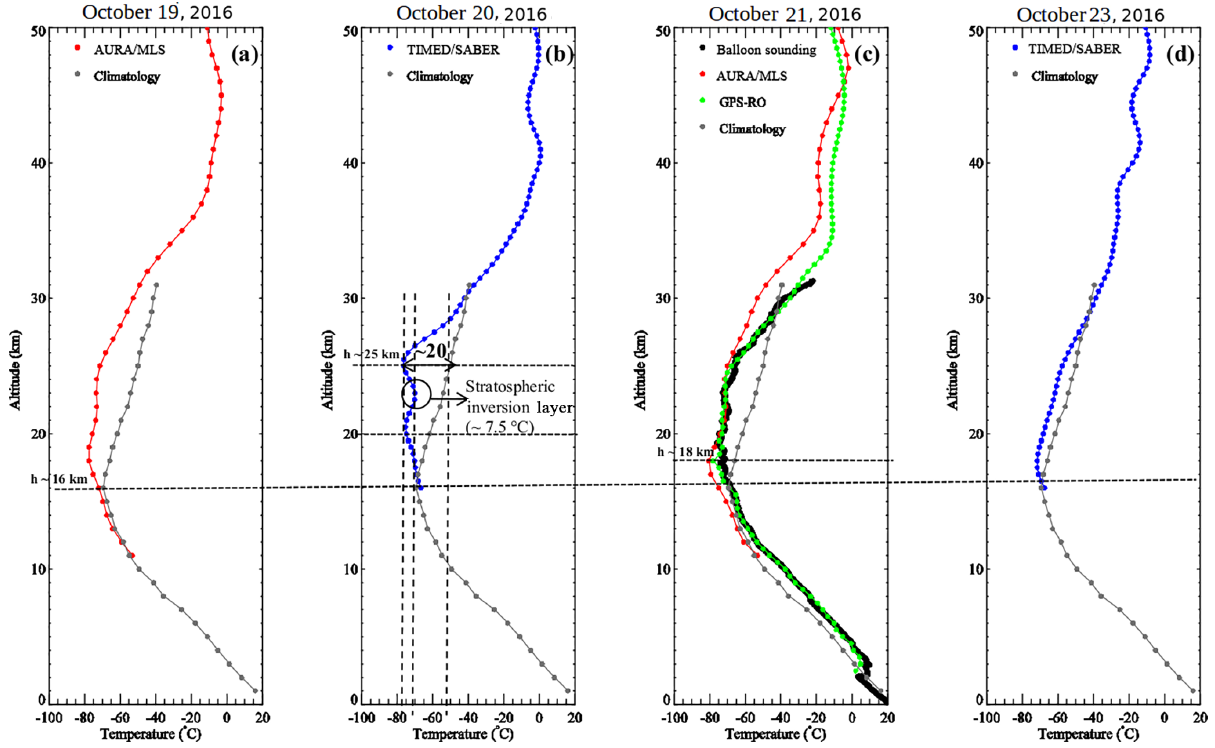
Figure 4. The same as Fig. 3 but for the temperature and the additional GPS-RO profile (green).